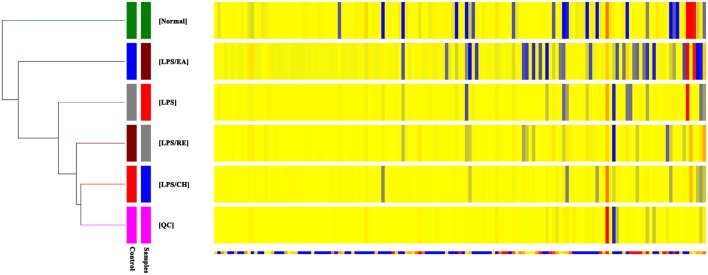
Heatmap visualization for different extracts of P. multiflorum. Rows: samples; Columns: metabolites (ESI- mode).